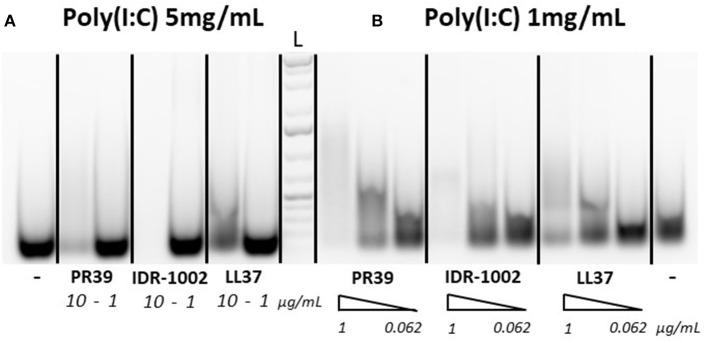
Peptide interactions with poly(I:C). Peptides were incubated with either 5 mg/mL (A) or 1 mg/mL (B) of poly(I:C) for 30 min at 37°C in 20 μL final volume and run on a 1% agarose gel. Poly(I:C) was detected with ethidium bromide. Peptides were used at concentrations of 10 or 1 μg/mL [A with 5 mg/mL poly(I:C)] or with a gradient (triangle shape symbol) of 1, 0.25, and 0.062 μg/mL [B with 1 mg/mL poly(I:C)]. A representative result of three experiments which provided similar results is shown. L, Ladder.